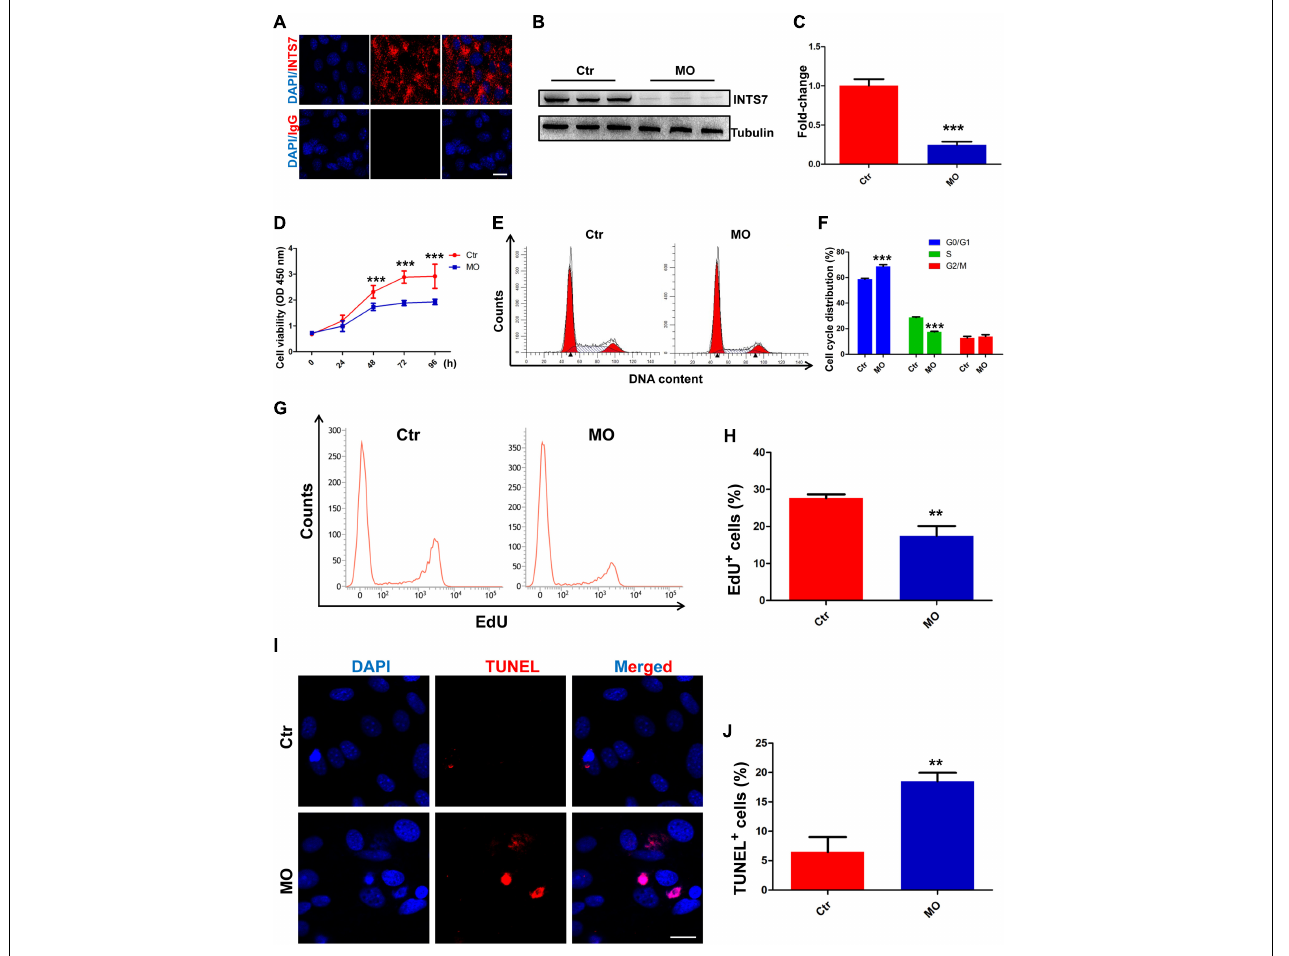
FIGURE 1 | INTS7 inhibition affects BM-MSC proliferation and apoptosis in vitro . (A) Immunofluorescent staining was performed to detect the subcellular localization of INTS7 protein. INTS7 protein is labeled in red, and the cell nuclei are labeled in blue. (B,C) Western blot analysis of INTS7 protein after treatment with Inst7 -MO oligos or negative control MO oligos (Ctr) for 48 h, n = 3. (D) Cell counting kit-8 (CCK-8) assays were used to determine the proliferation capacity of INTS7-depleted BM-MSCs, n = 6. (E,F) Flow cytometric analysis was used to determine the cell-cycle distribution of BM-MSCs after the treatment with Ints7 -MO oligos for 48 h, n = 3. (G,H) An EdU-based flow cytometric analysis was conducted to evaluate EdU-positive BM-MSCs in the INTS7-depleted group compared with the Ctr group after treatment for 48 h, n = 3. (I,J) TUNEL assays were performed to determine BM-MSC apoptosis after INTS7 suppression for 48 h. The TUNEL-positive cells are labeled in red, and the cell nuclei are labeled in blue, n = 3. Scale bar, 20 µ m. ** p < 0.01; *** p < 0.001, Student’s t -test.